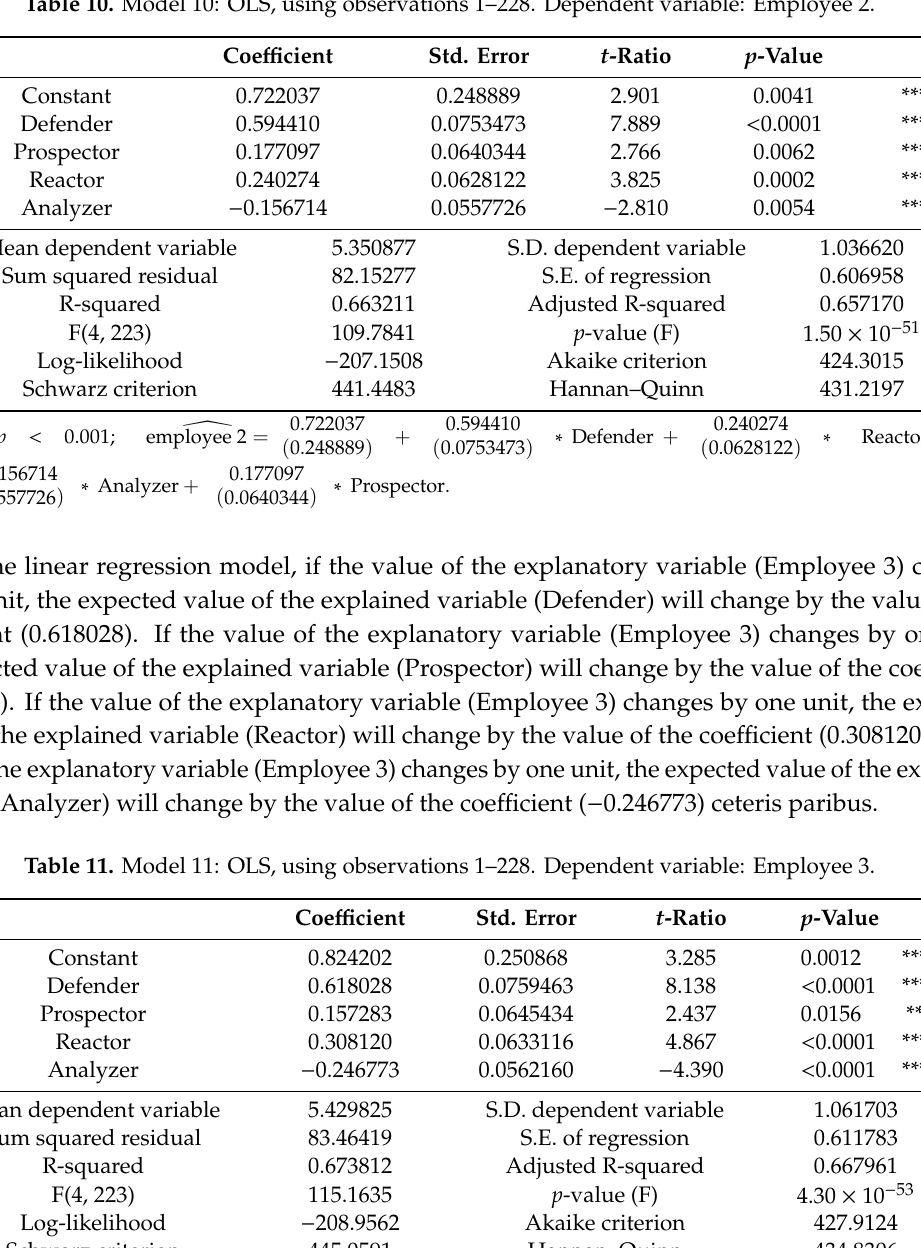
Table 10. Model 10: OLS, using observations 1–228. Dependent variable: Employee 2.